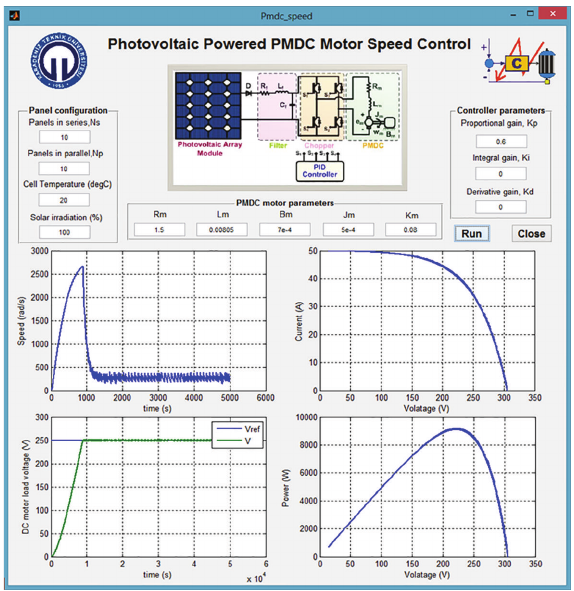
Figure 5: The PV powered PMDC motor interface.